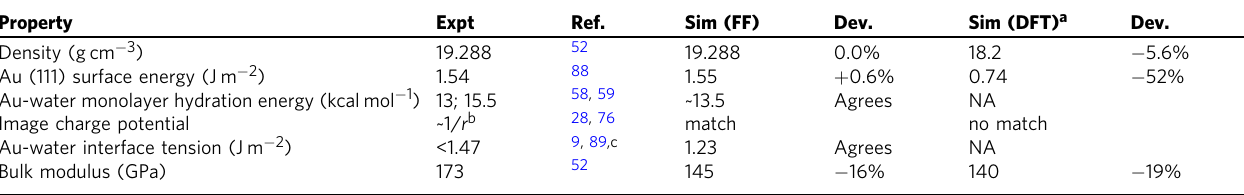
a Using the PBEfunctional. Similar deviationsare also observed with other density functionals (ref. 16 ).The simulation of hydrationenergies and interfacial tensions by ab-initiodynamics is dif fi cult due to limitations in time scale (>100ps using IFF) b The image charge potential of a single ion in vacuum is inversely proportional to the distance r from the metal surface c Experimental data for the Au-water interfacial tension are based on a contact angle of 0° and the Young equation and provide an upper limit, not an exact value (refs. 10,89 ). The computed Au-water interfacial tension of 1.23Jm − 2 corresponds to an Au-water interfacial energy of 1.17Jm − 2 and an entropy contribution of + 0.06Jm − 2 as water molecules partially lose mobility upon adsorption (see ref. 10